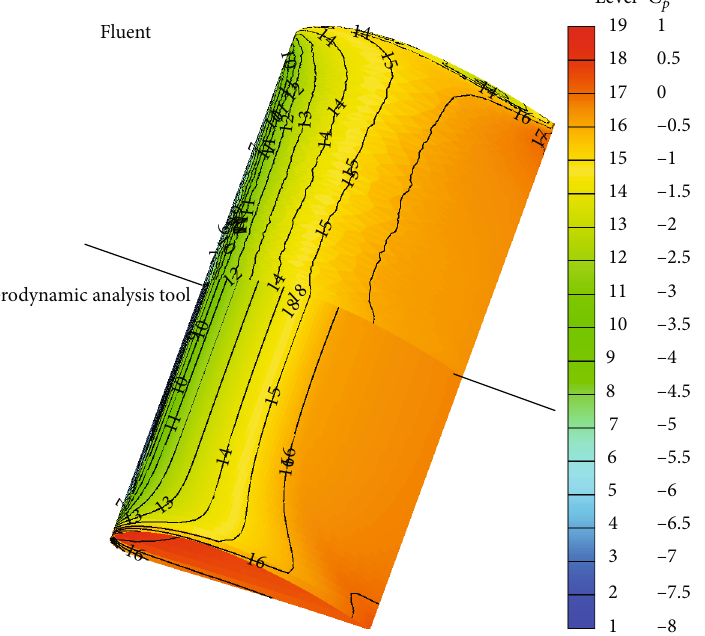
Figure 8: C contours of the aerodynamic analysis tool and ANSYS-Fluent for 18 ° p